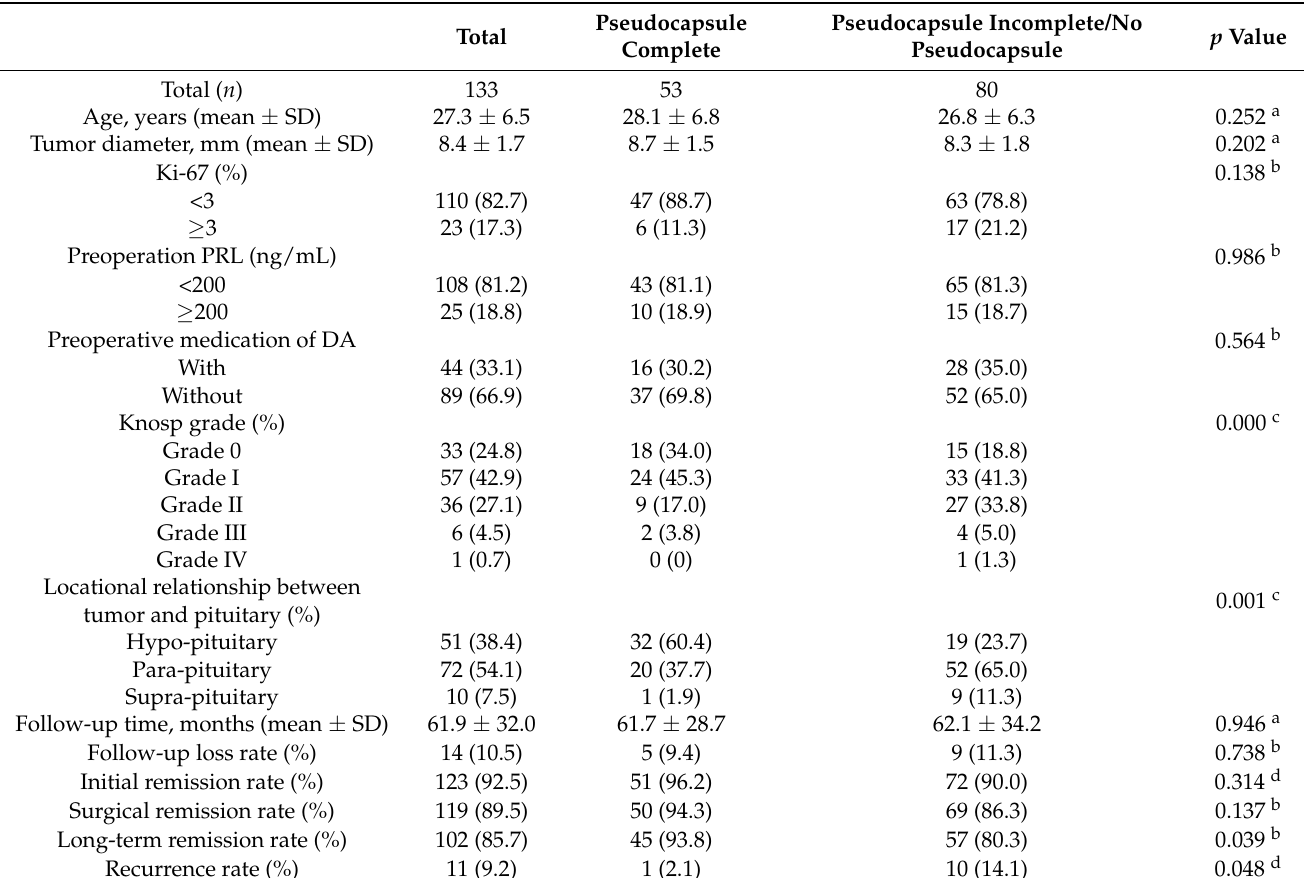
Table 3. Baseline characteristics of pseudocapsule classification in 133 female patients with pituitary prolactin